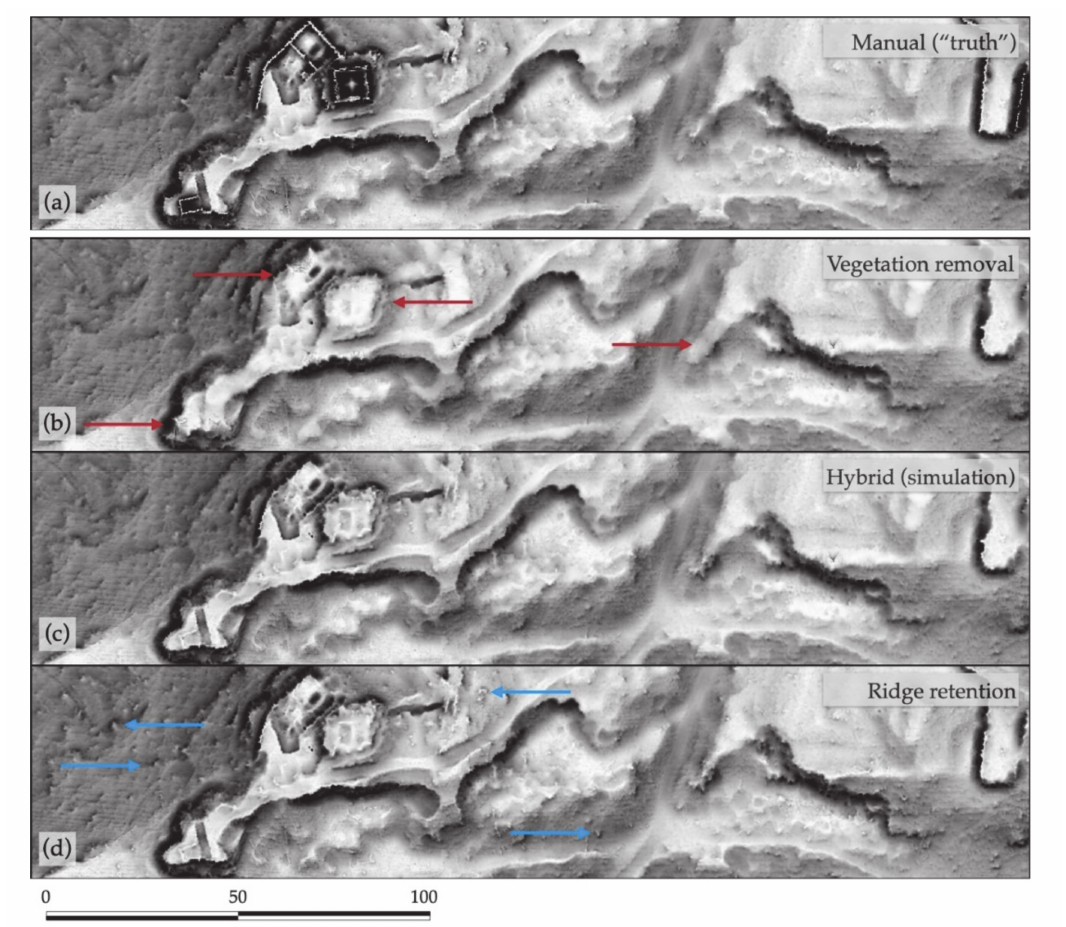
Figure 6. Test site AT simulated segmentation classification filter combining the strengths of filters optimized for vegetation removal and ridge retention: ( a )—manual reclassification representing the ground “truth”; ( b )—filter optimized for vegetation removal; ( c )—simulated segmentation filter; ( d )—filter optimized for ridge retention. Red arrows indicate noise typical of vegetation removal optimization and blue arrows indicate ridge retention optimization; neither is present in the hybrid filter. DFM processing: point cloud processing optimized for ridge retention with slope-based filter (implemented in WhiteboxTools: LidarGroundPointFilter); grid cell size 0.25 m; other processing according to Table